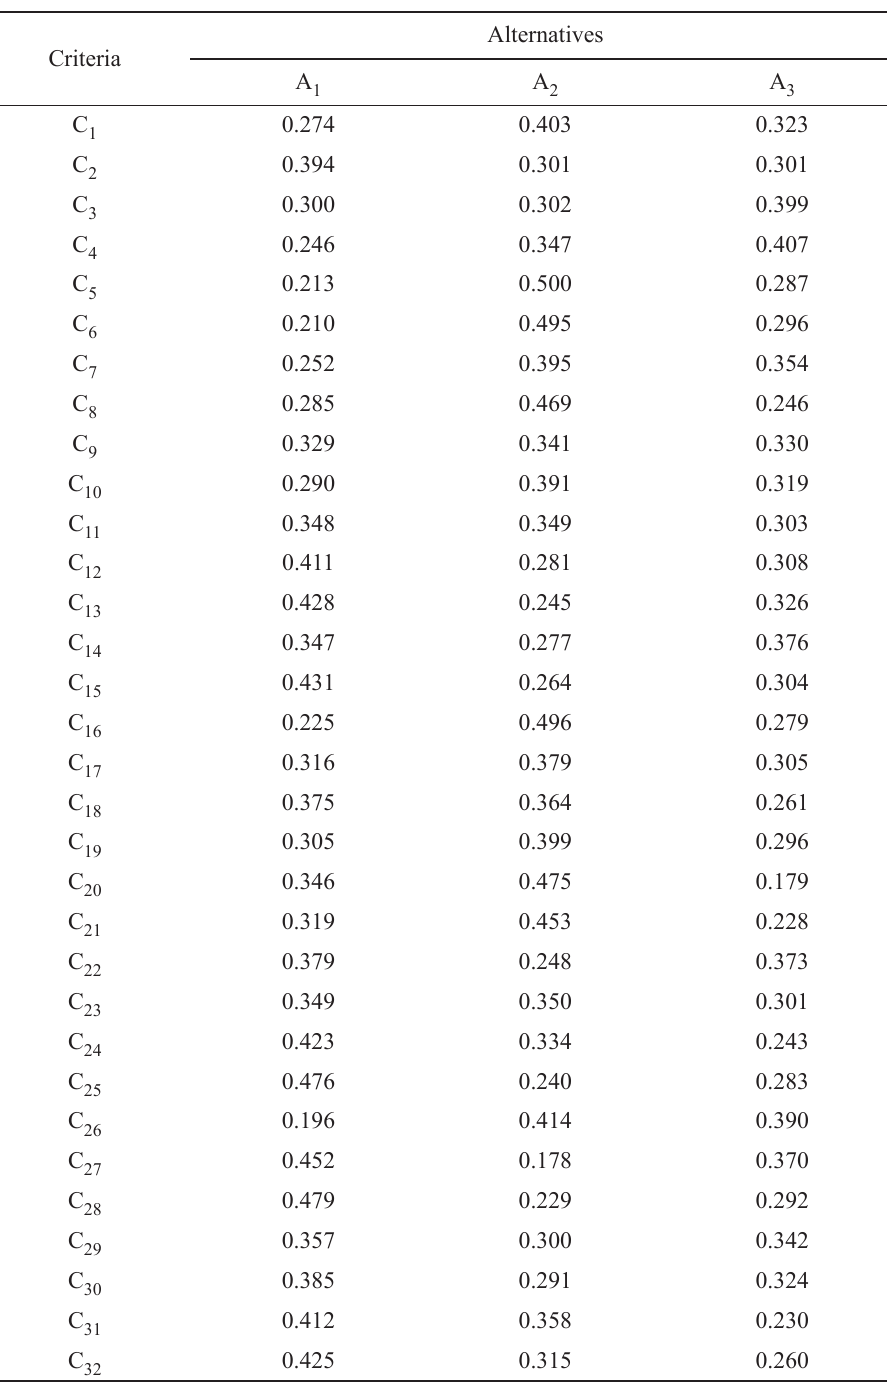
Table 15. The weights of the alternatives under each